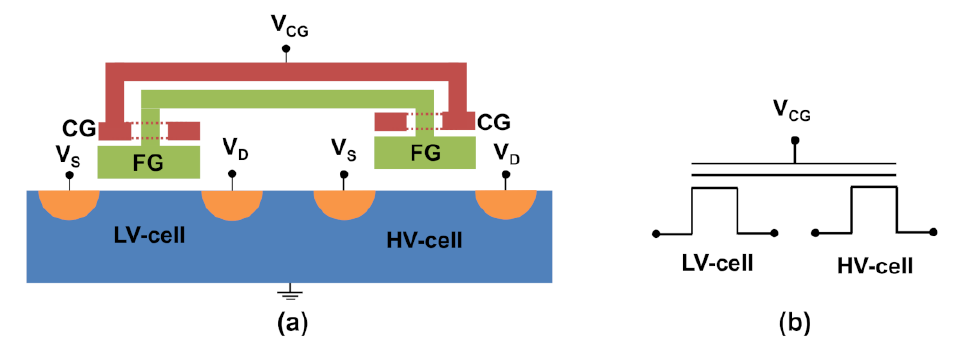
Figure 3. Schematic cross-section view ( a ) and equivalent circuit ( b ) of the test device. Adapted from